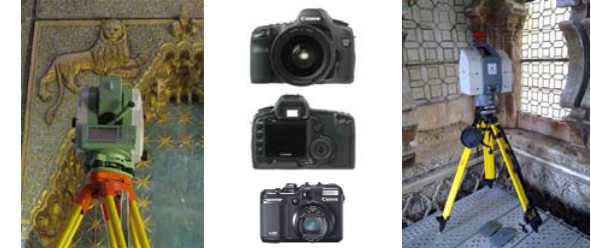
Figure 3. Left: Leica TCRA 1203 with diagonal eyepiece for point measurements in the upper part of the chapel. Middle: front and rear views of SLR EOS D5 and Powershot G10 cameras. Right: TLS Scanstation HDS3000 set up on scaffolds at the vault level.